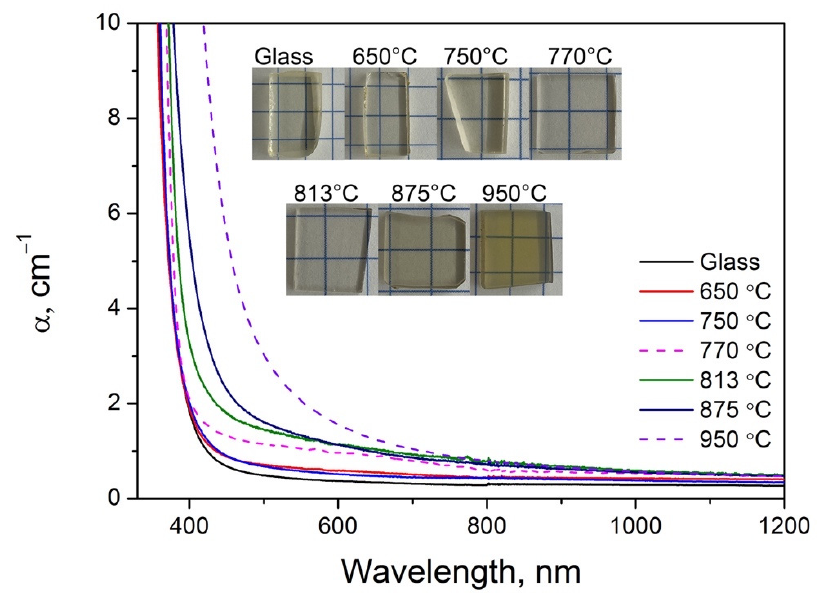
Figure 10. Absorption spectra of the Matrix glass samples before and after treatment at the indicated temperatures for 20 h. Inset—photos of the samples.